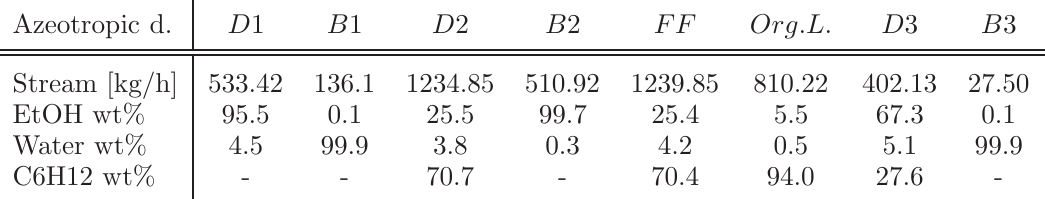
Table 8 Technological streams of adiabatic pervaporation, D+PV+D. Azeotropic